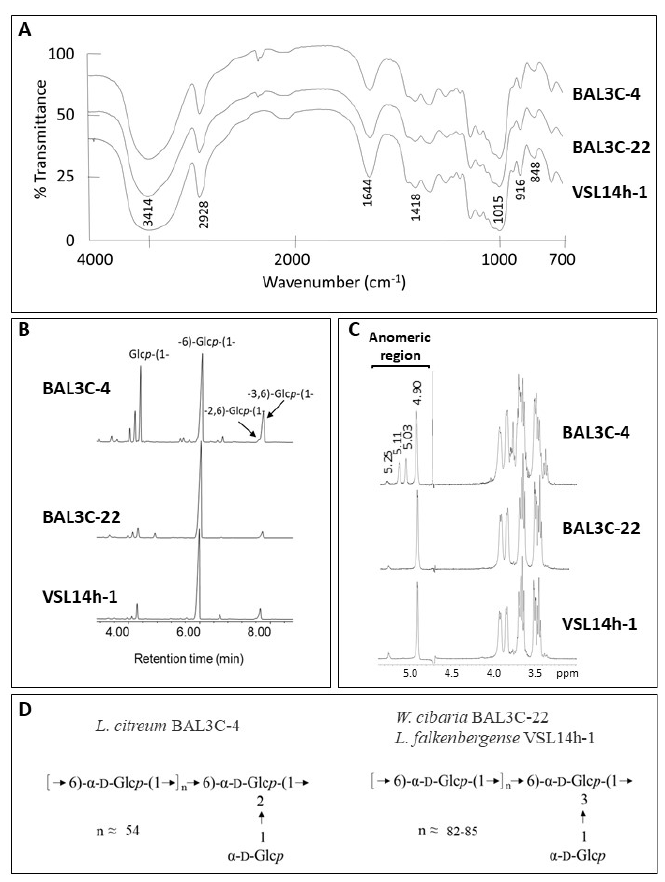
Figure 8. Structural characterization of the dextrans produced by L. citreum BAL3C-4, W. cibaria BAL3C-22, and L. falkenbergense VSL14h-1. ( A ) Infrared spectra of the exopolysaccharides ( B ) EPS bonds deduced from the methylation analysis. ( C ) Representative 1 H-NMR spectrum of the polysac- charides. ( D ) General structure of the